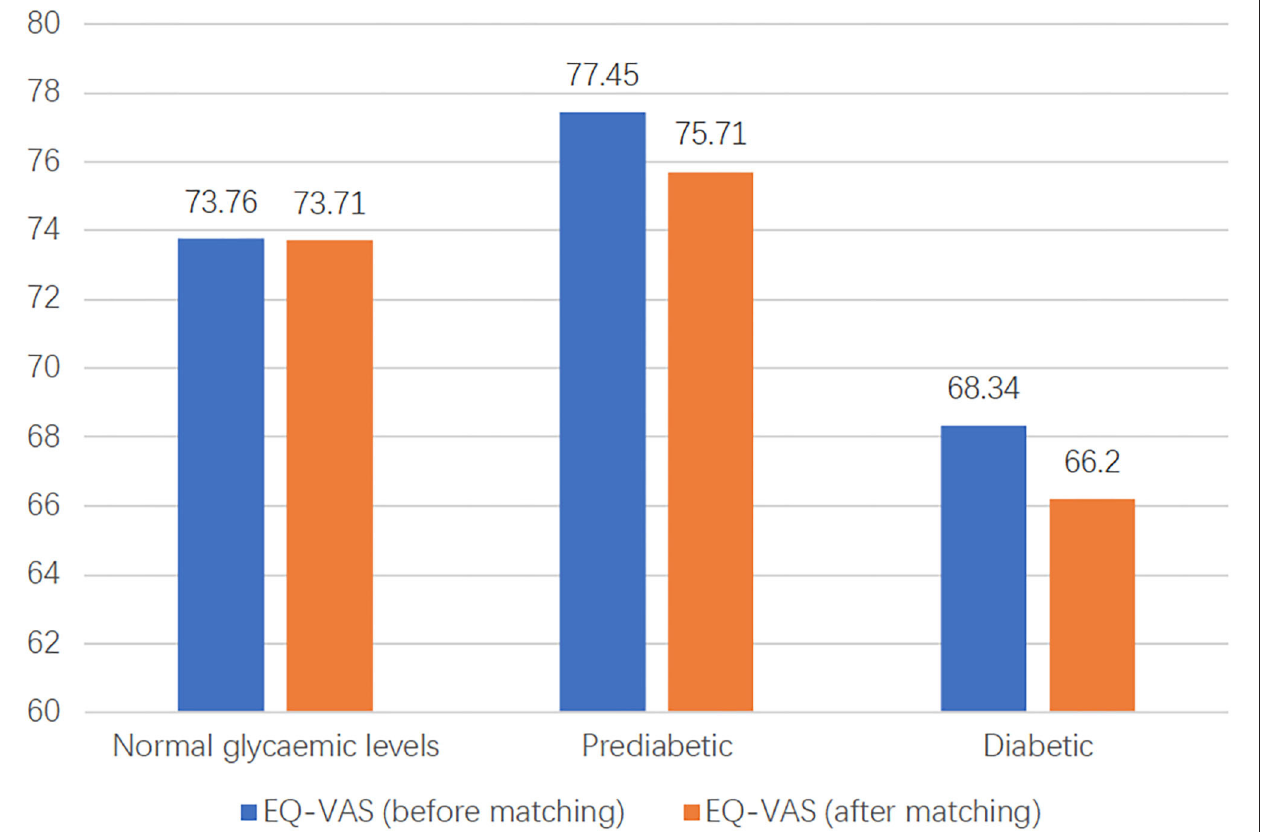
FIGURE 4 | The distribution of EQ-VAS of three groups before and after matching. EQ-VAS, EuroQol-visual analog